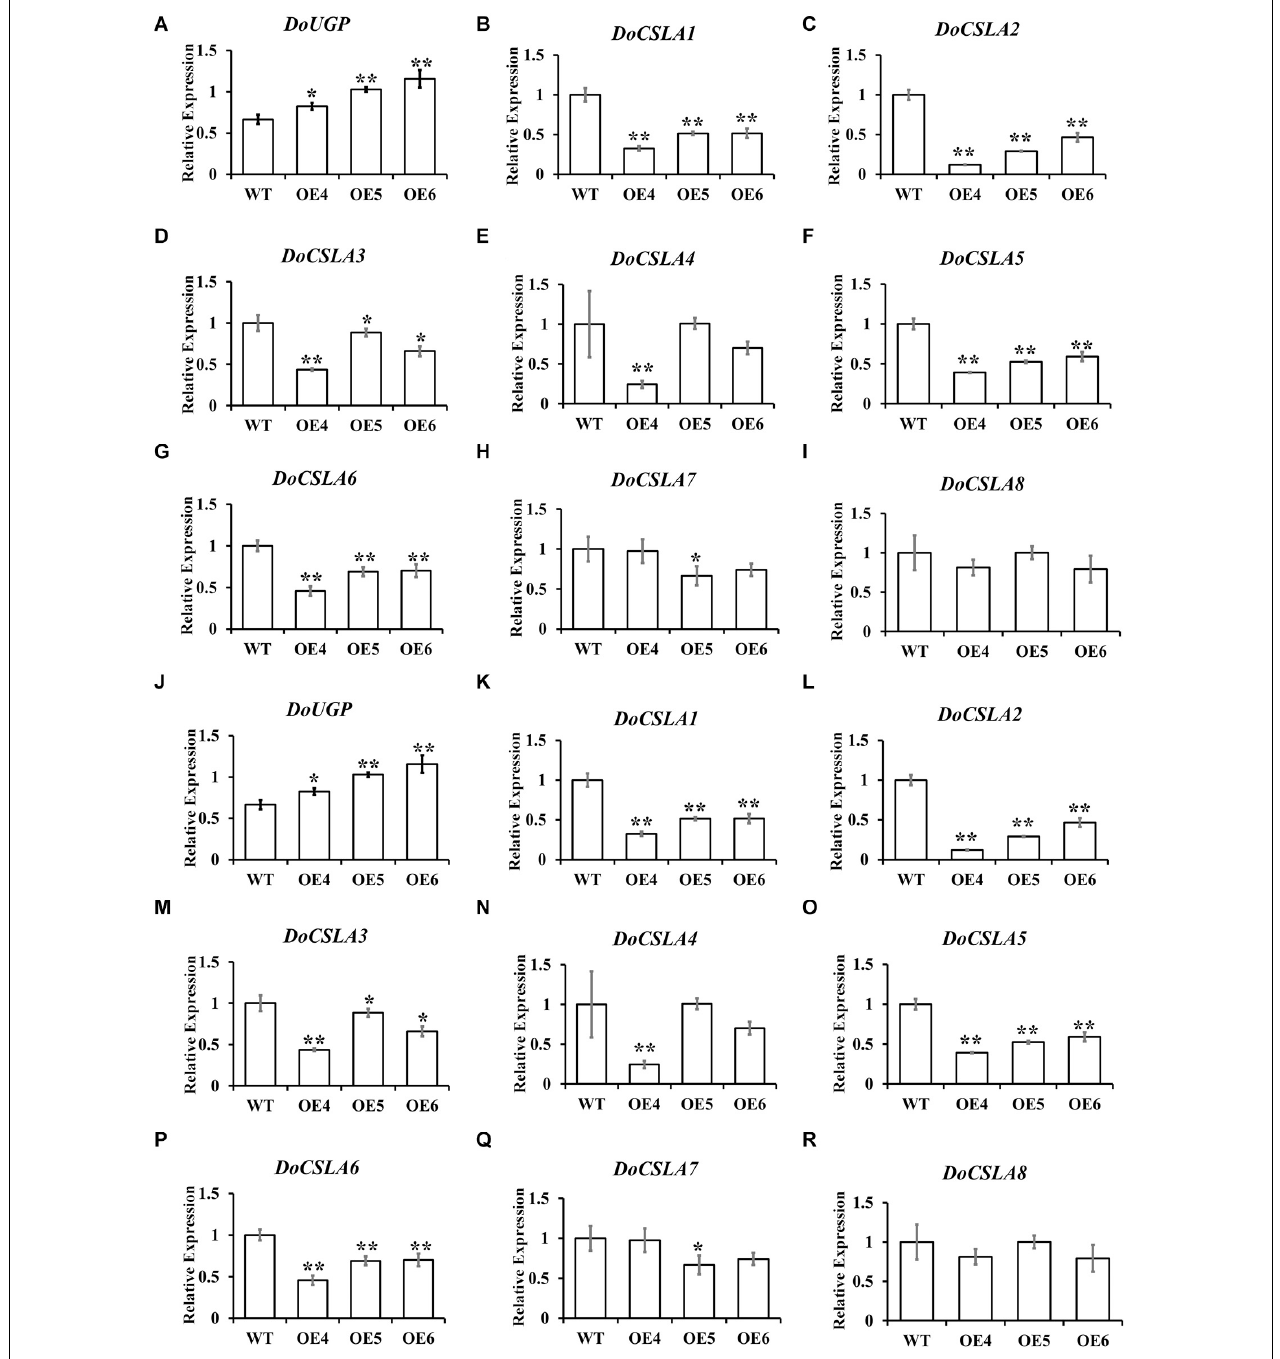
FIGURE 5 | Expression levels of cellulose synthase-like A ( CSLA ) family genes in stems (A–I) and leaves (J–R) of DoUGP overexpression plants. Results are presented as mean ± standard error calculated from three biological replicates. Asterisks indicate the statistically significant differences (Student’s t -test, p < 0.05).